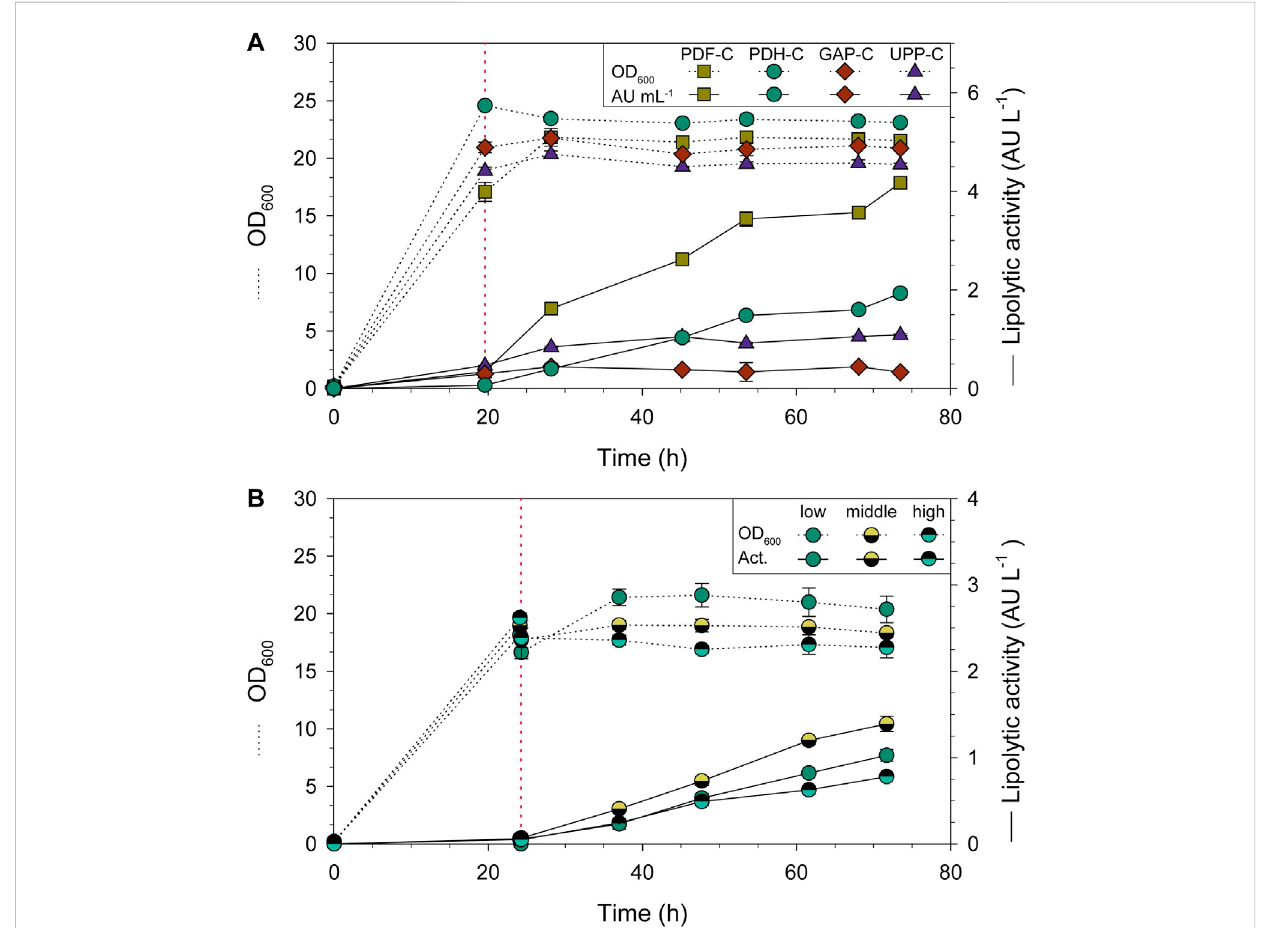
FIGURE 3 Shake- fl ask cultivations of CalB producing strains using three glycerol FeedBeads ® (addition time is indicated by red dotted lines). Time-course evolution of OD 600 (dotted line) and lipolytic activity (solid line). (A) PDH-C performance is compared to the benchmarks GAP-C, UPP-C and PDF-C. (B) OmoticshockcultivationsofPDH-Catlow,middleandhighosmolarities.Theredlinealsoindicatesthe10 mLadditionofwaterorKClsolution.Theerror bars indicate the standard deviation between biological